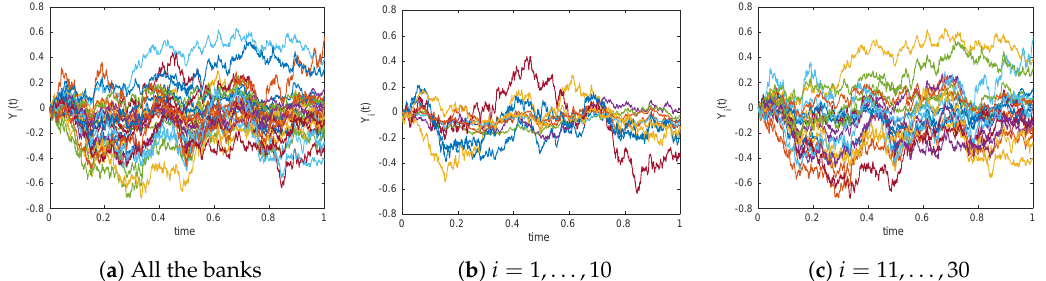
Figure 3. Evolution of Y i ( t ) , which represents the log capital of the i th bank. We use the following parameters: interest rate r = 8%, N = 30 banks, time horizon T = 1, correlation coefficient ρ 0 = 0.5, interbank flows c i , j as in Equation (38), 1000 time steps and µ i , σ i , i = 1, . . . , N i.i.d. uniform [ 0.1,0.2 ] .